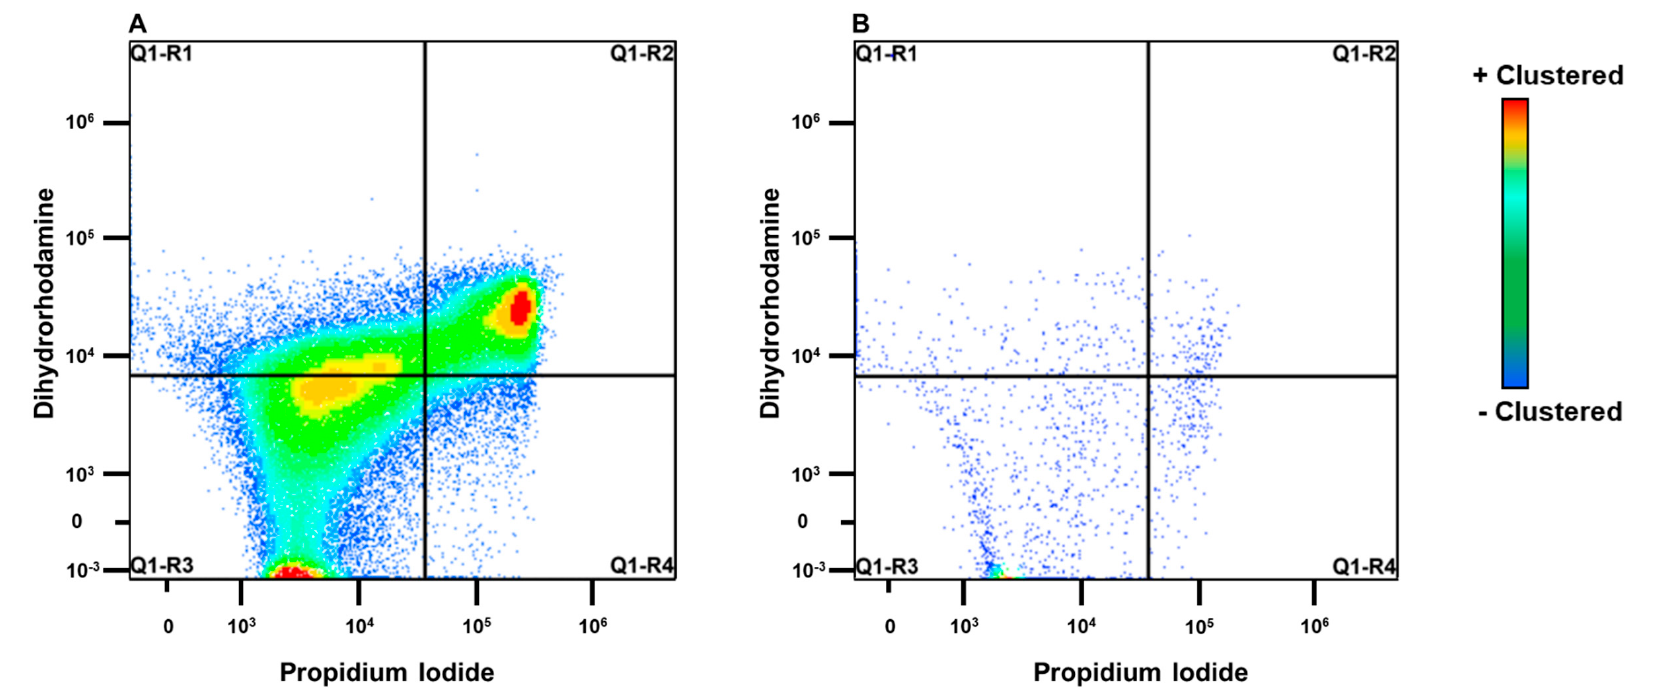
Figure 2. Representative density plot on flow cytometric analysis for a chronic ( A ) and a control cow ( B ). The image is plotted specifically for neutrophils, after the isolation and the staining protocol. The quadrant representing neutrophils that presented low fluorescence for both propidium iodide (PI) and dihydrorhodamine (DHR) is indicated in Q1-R3. Neutrophils presenting high fluorescence only for PI are indicated on quadrant Q1-R4, and neutrophils presenting high fluorescence only for DHR are indicated on quadrant Q1-R1. The quadrant Q1-R2 indicates neutrophils presenting high fluorescence for both PI and DHR. On the Y and X axis, there is the fluorescence intensity for each dye